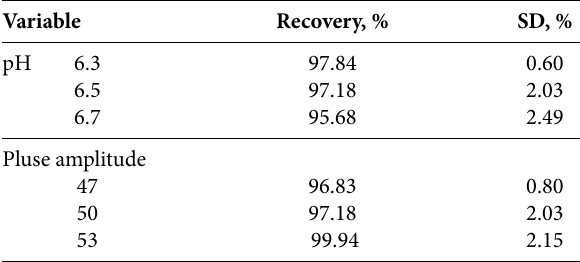
Table 3. Robustness results of the proposed method.